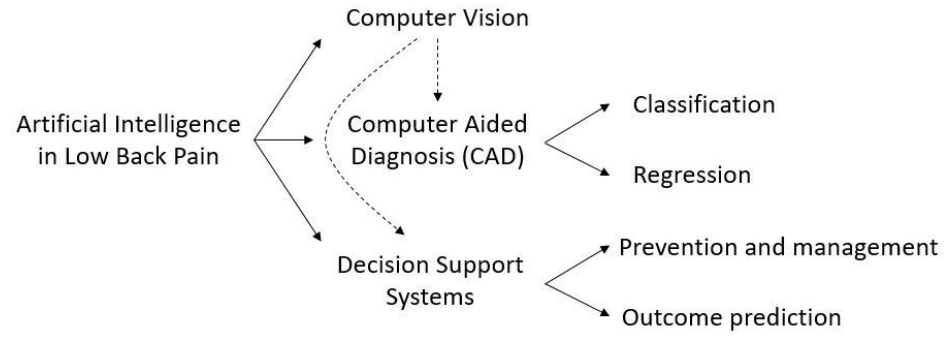
Figure 1. Partitioning of the studies concerning the application of AI in LBP, presented in